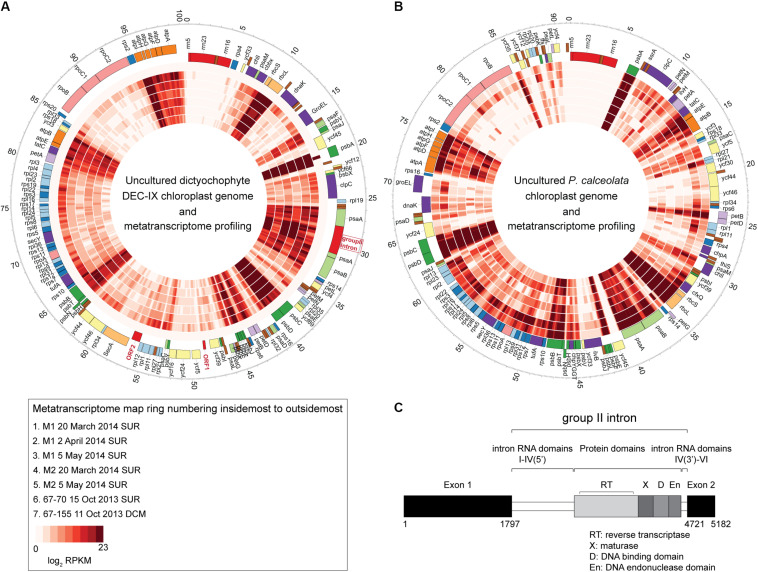
The complete chloroplast genome of (A) uncultured dictyochophyte DEC-IX (B) and wild P. calceolata (Worden et al., 2012), and transcriptional activity in the ENP. Recruitment of metatranscriptomic reads (inner layers) at ≥ 99% nucleotide identity shown as mapped reads binned at 100 bp increments and log2 transformed for the heat plots which reflect the normalized transcripts. While the metatranscriptomes were unreplicated and therefore unsuitable for quantifying expression, qualitatively, similar patterns of expression were observed for genes present in both the DEC-IX and P. calceolata chloroplast genomes. All come from surface samples except the 67-155 metatranscriptome (100 m, DCM). Outermost ticks represent kilobase pairs (chloroplast genome size). (C) Structure of the psaA gene group II intron, showing upstream and downstream exons, intron domains and conserved IEP consisting of a reverse transcriptase (RT), a maturase domain (X), a DNA-binding domain (D) and an endonuclease domain (En).